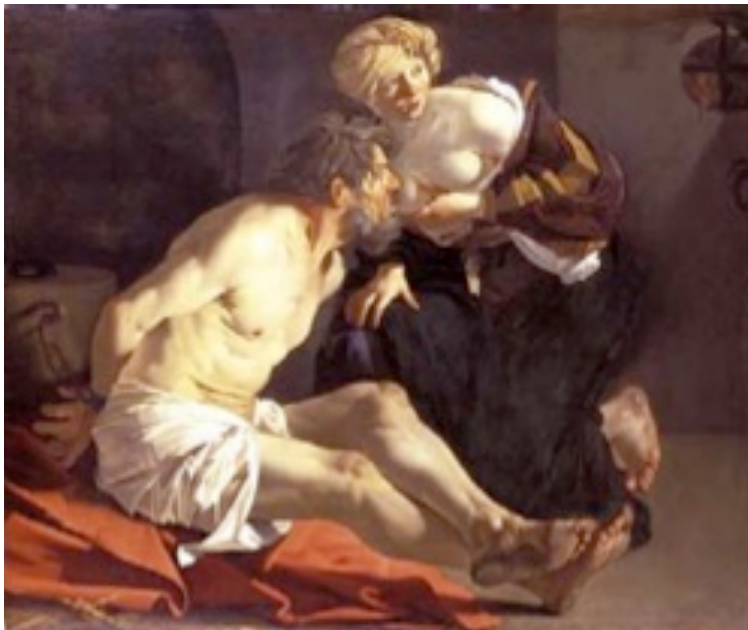
Fig. 7. Dirck Van Baburen, Roman Charity, Cimon and Peres, 1623. Oil on canvas, 127 x 151 cm. York City Art